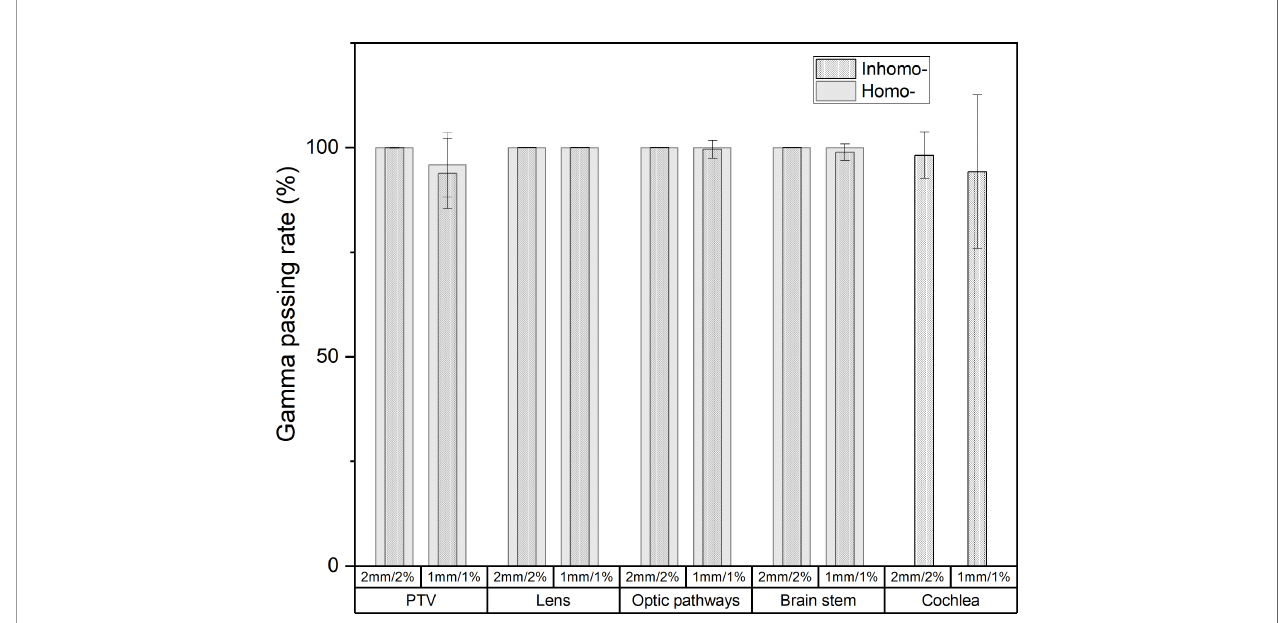
FIGURE 4 | The post-CA and pre-CA 3D gamma difference of the target and all OARs for inhomo- and homo-cases. At the criterion of 1 mm/1%, the target gamma pass rate of the homo-case (95.89%) was larger than that of the inhomo-case